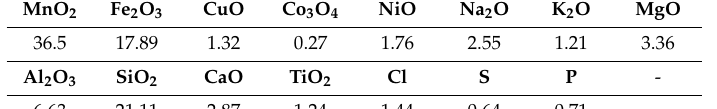
Table 2. Chemical composition analysis of the ocean manganese nodules (wt.%).